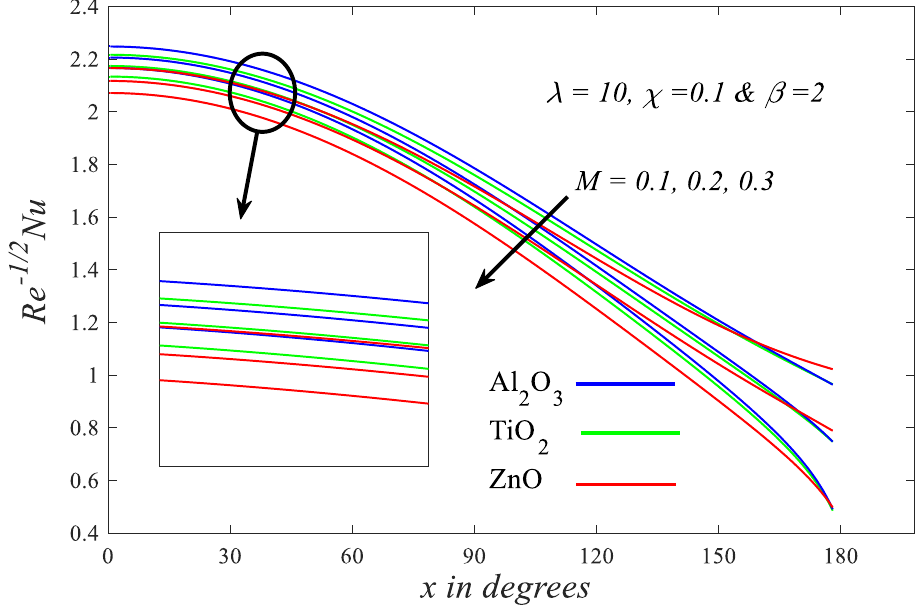
Figure 8. Impression of M on Re − 1/2 Nu . The inset is a partial enlargement of the curves.